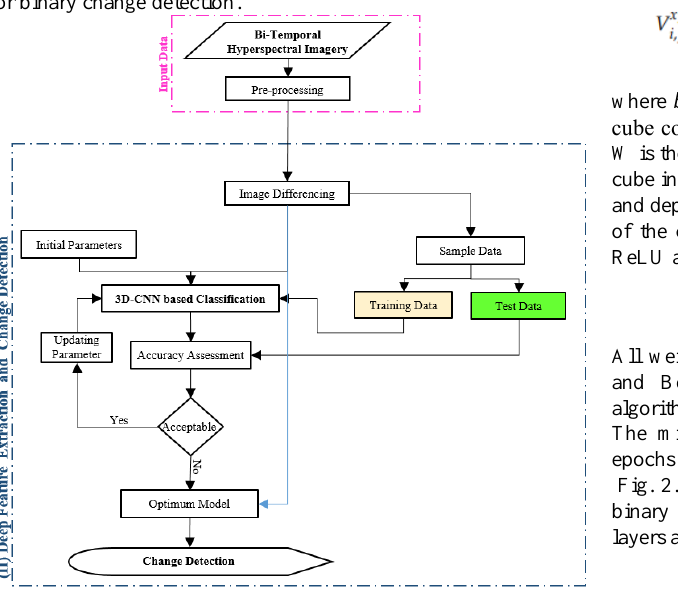
Fig.1. Flow chart of the proposed HCD method.